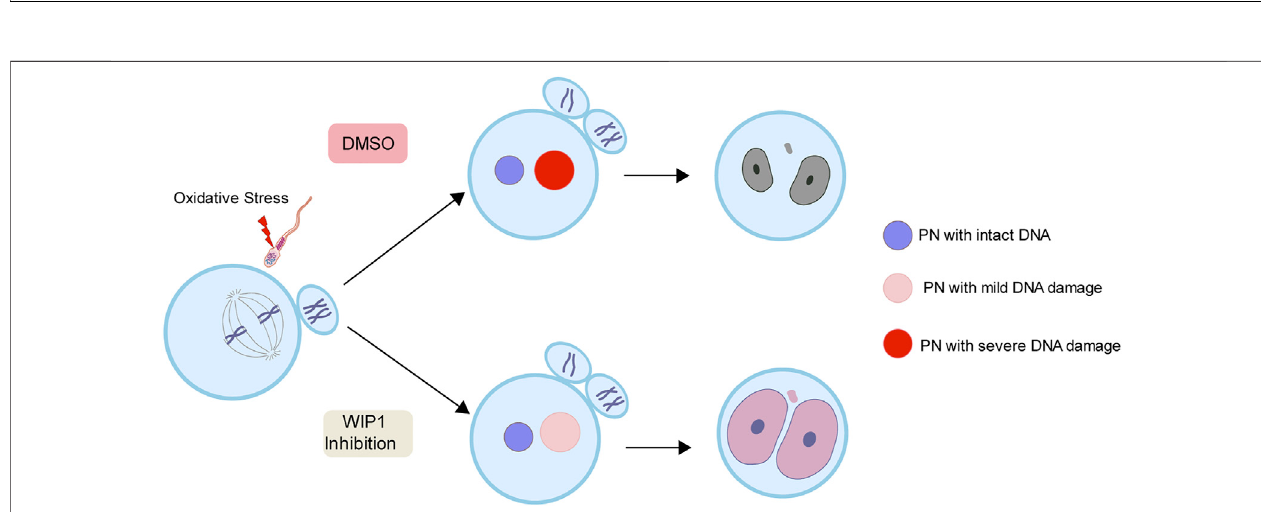
FIGURE 4 | A working model for the effect of WIP1 inhibition on the repair of sperm-derived DNA damage in zygotes. Oxidative stress in sperm increases paternal DNA damage in zygotes and causes ZGA failure. However, WIP1 inhibition during fertilization reduces paternal DNA damage in zygotes and restores ZGA. PN,